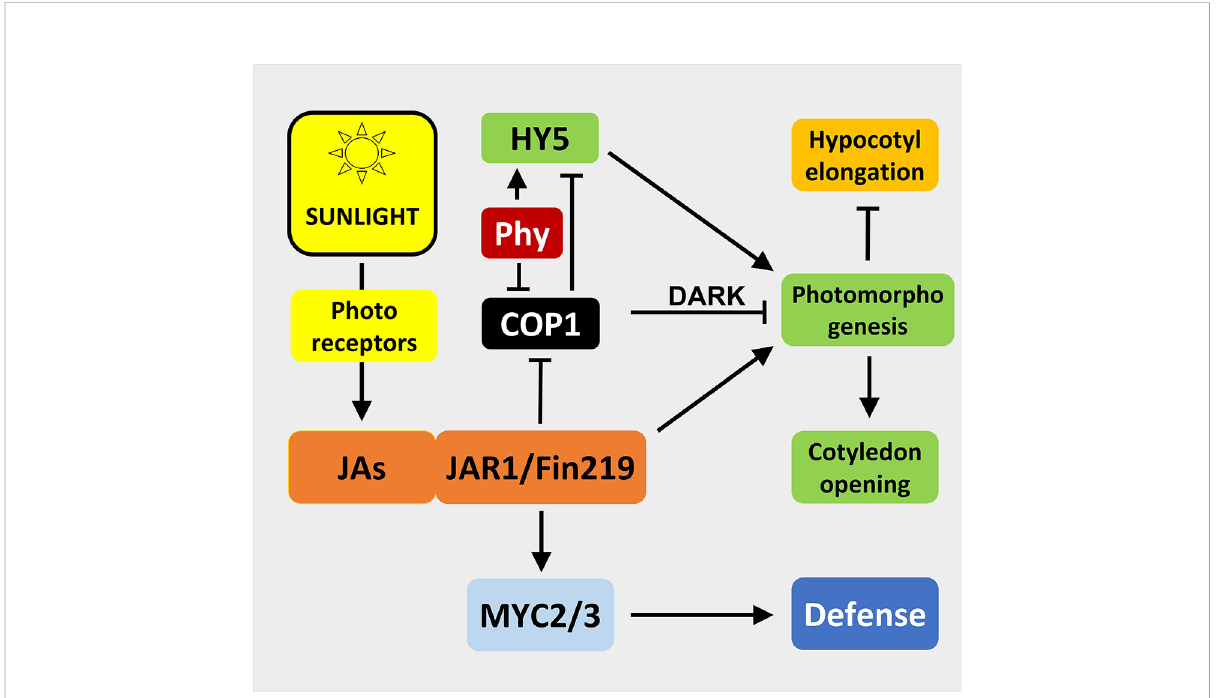
FIGURE 3 Illustration of interactions among sunlight, jasmonates, photomorphogenesis, and defense. Arrows imply activation, T-bars indicate inhibition of an interaction/process. JAs, jasmonates; JAR1/FIN219, Jasmonate resistant1/Far-red insensitive 219; COP1, Constitutive photo-morphogenic1, acts only in the dark on photomorphogenesis; Phy, Phytochrome; HY5, Elongated hypocotyl 5; MYC2/3, Transcription factors; photoreceptors include phytochrome, blue light, and UV-B receptors; sunlight represent R:FR >> 1. For details see